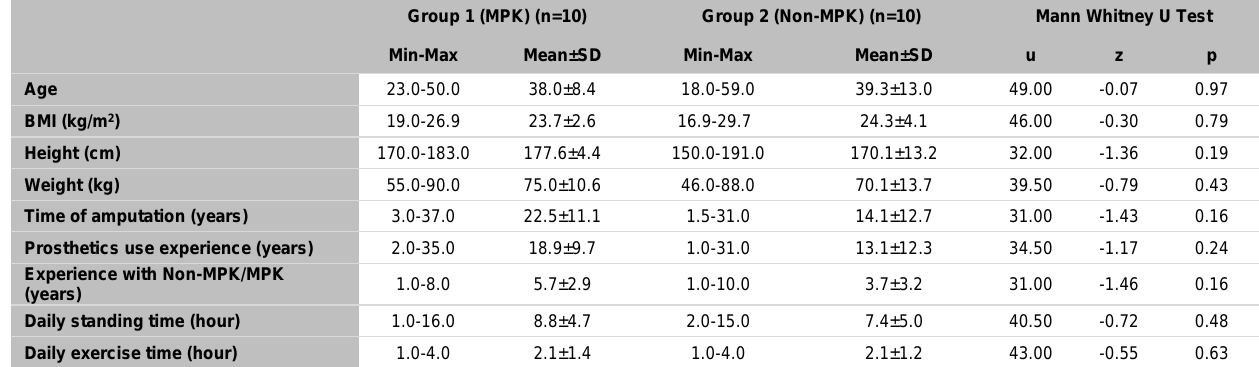
Table 1: Participant details